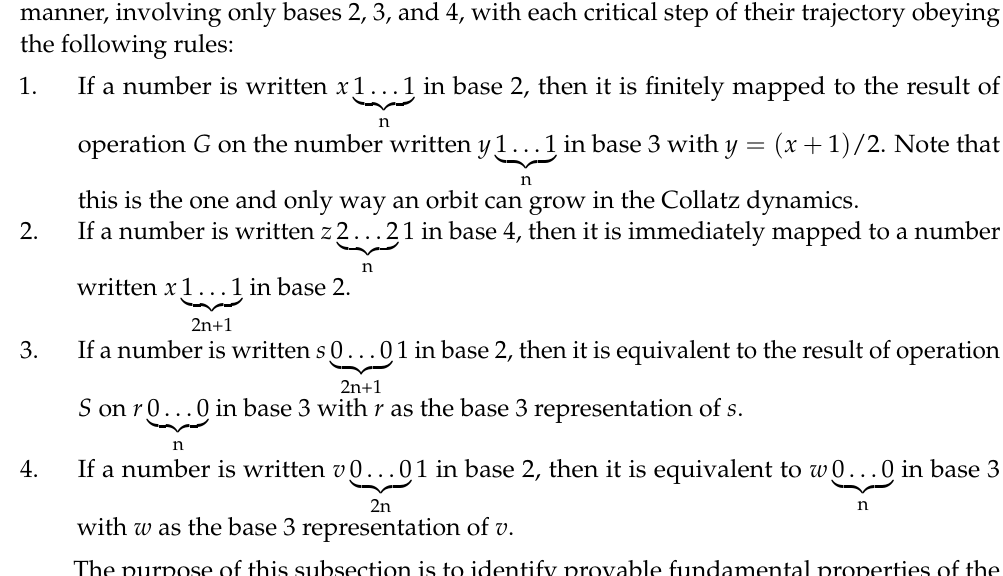
10 in red for comparison (log −